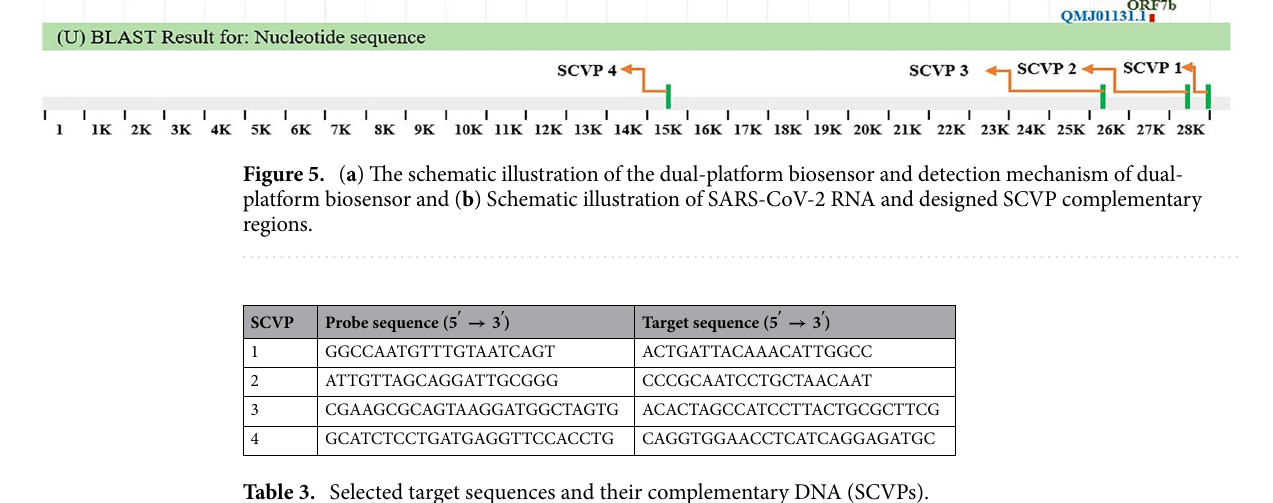
Table 3. Selected target sequences and their complementary DNA